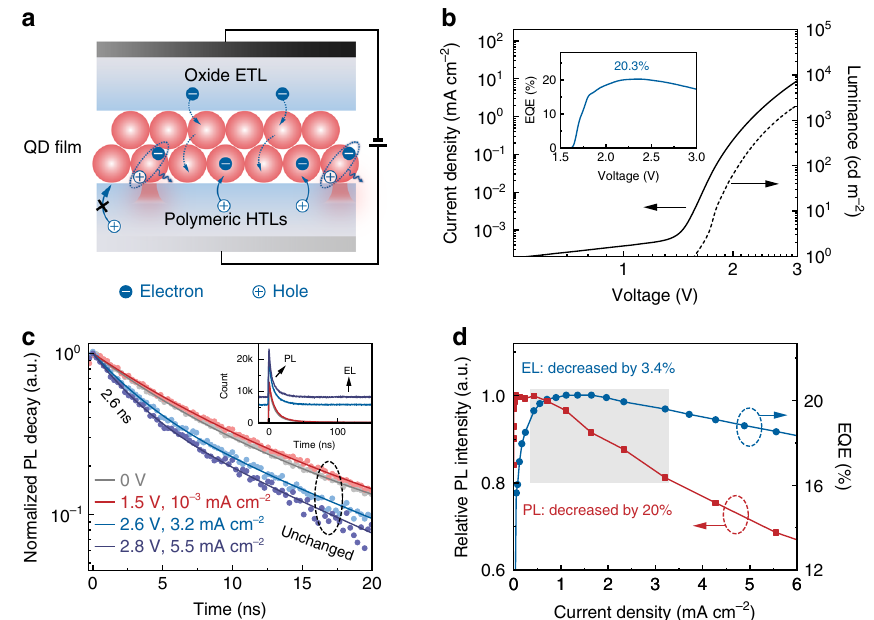
þ e þ h QD (cid:2) ! QD X ) in the QD-